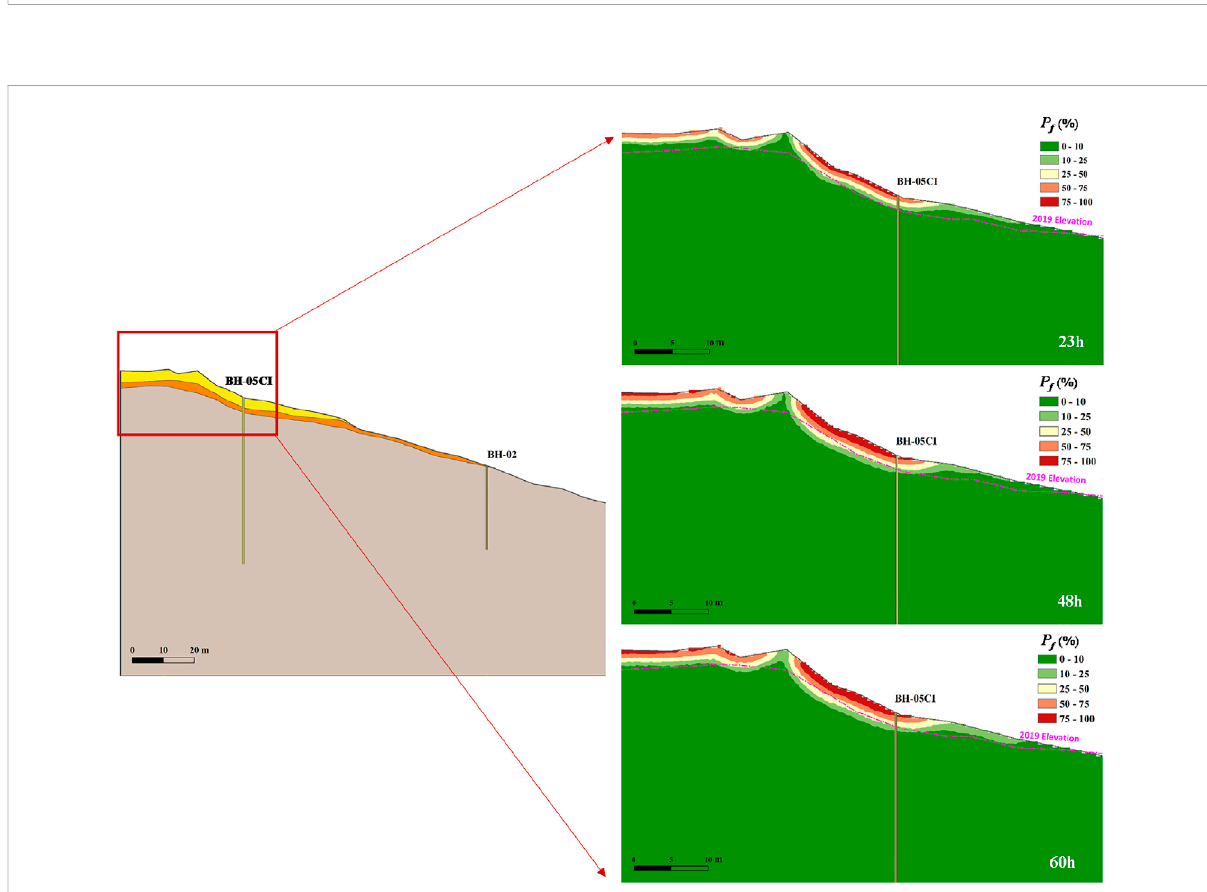
FIGURE 8 Distribution of probability of failure at 23, 48, and 60 h at the top of